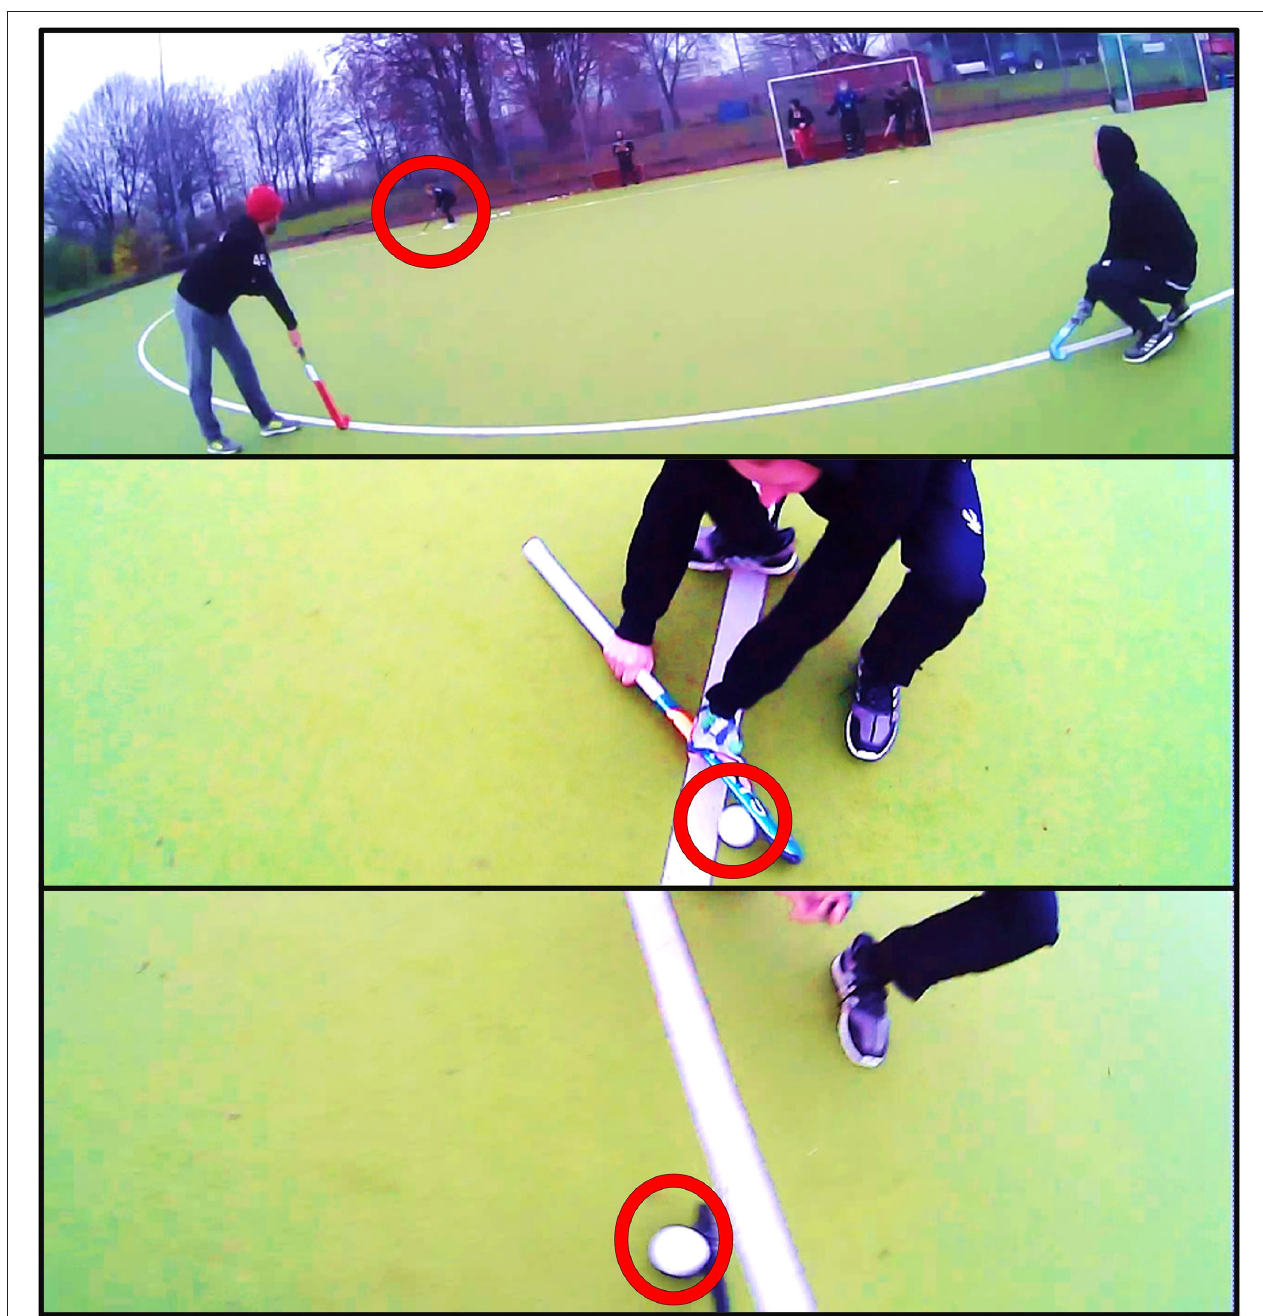
FIGURE 4 | Pictures of a penalty corner attempt from phase 1 (top) to phase 3 (bottom). Phase 1 starts the moment the ball is injected and ends when the ball reaches the stopper’s stick. Phase 2 has been defined as the period from the moment the ball leaves the stopper’s stick until the striker receives the ball. Phase 3 ended at the moment the pass to the teammate was played or ball was shot.